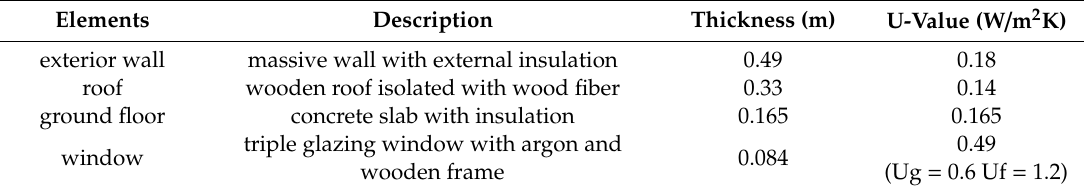
Table 2. Characteristics of the construction element.